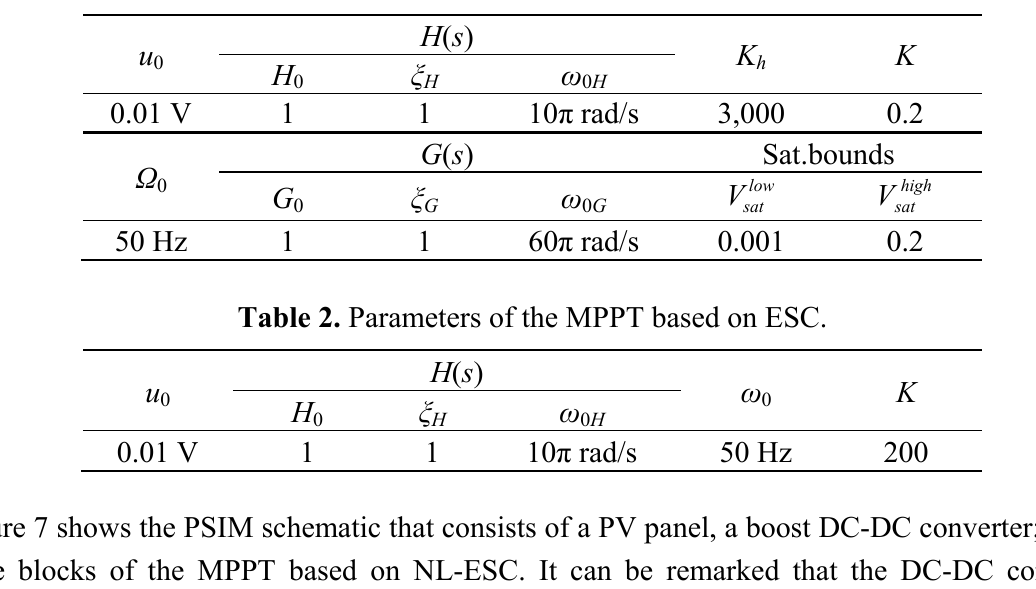
Table 1. Parameters of the MPPT based on NL-ESC.